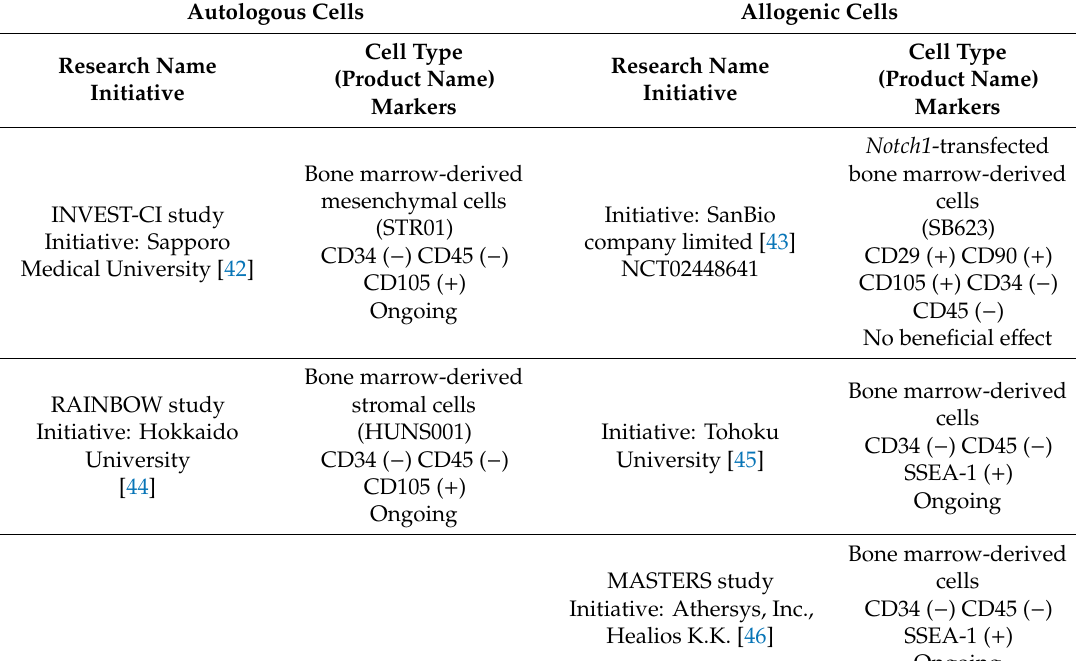
Table 1. List of bone marrow-derived mesenchymal / stromal stem cell therapies under clinical